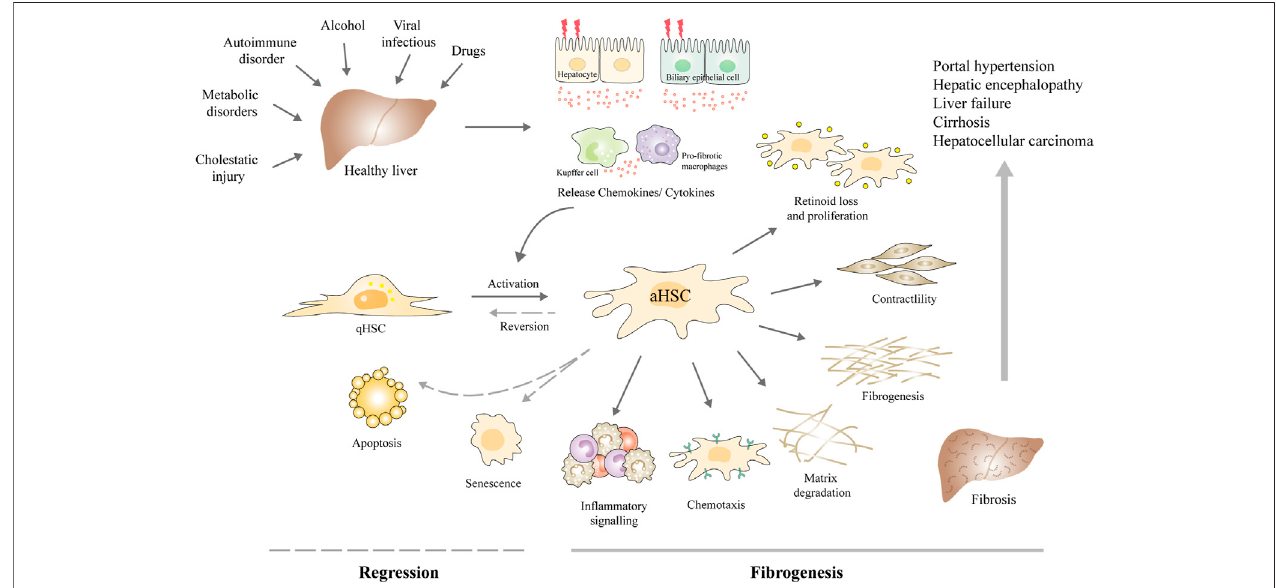
FIGURE 1 | Schematic diagram of the central role of HSCs in the fi brogenesis and regression of liver fi brosis. Upon various chronic liver injuries, the hepatocytes and biliary epithelial cells can be damaged, together with Kupffer cells and macrophages, release chemokines, and cytokines to activate the HSCs. aHSCs are prone to present characteristics including retinoid loss, proliferation, contractility, ECM production, altered matrix degradation, chemotaxis, and expressing in fl ammatory signals. Liver fi brosis may develop into cirrhosis and even liver cancer, along with a suite of complications, such as portal hypertension, hepatic encephalopathy, and liver failure.Currently,themainanti fi brotictherapystrategiesareinhibitingHSCactivationandproliferation,reversingtheactivationphenotypetothequiescentphenotype,or inducing HSC apoptosis and senescence. Abbreviations: qHSC, quiescent hepatic stellate cell; aHSCs, activated hepatic stellate cell.